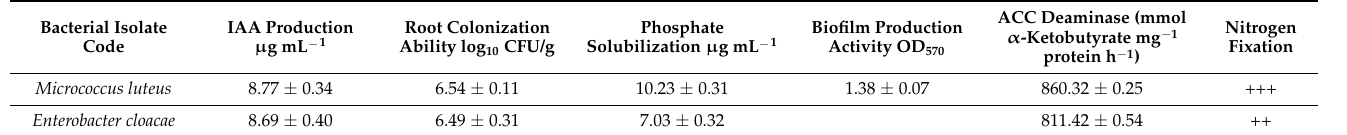
Table 2. Patterns of the most potent plant growth-promoting endophytic bacterial isolate. ++ +++ (positive).